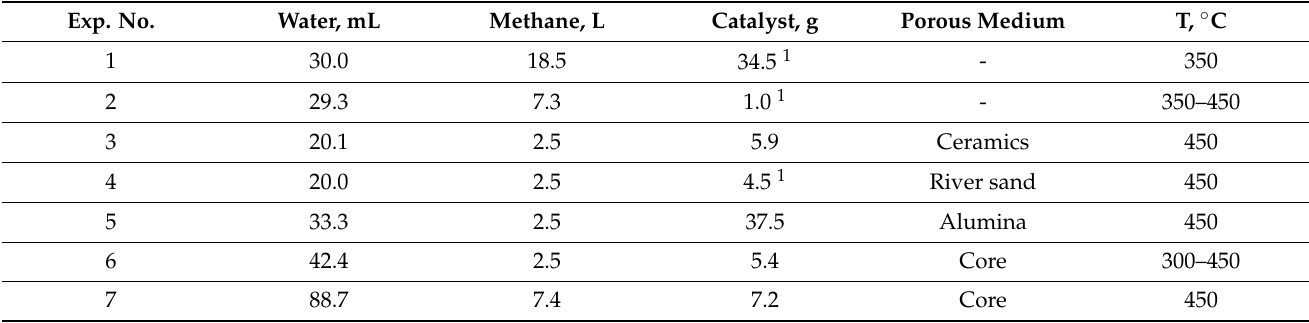
Table 3. Reagent loads and experimental